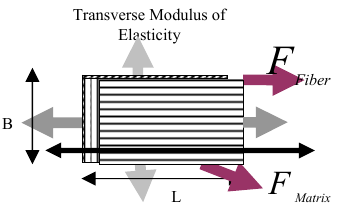
Figure 8: Composite structure having aligned fibers at unique orientation in each plane of the